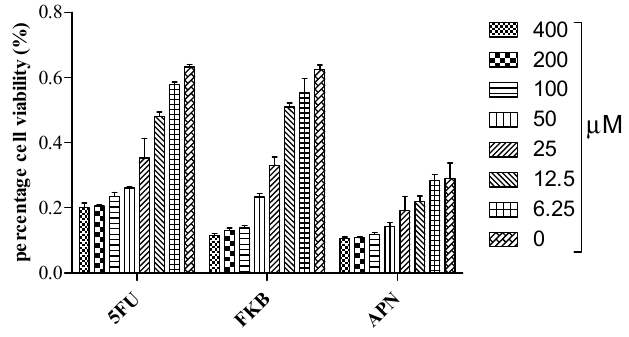
Figure 1. Percentage cell viability of HT 29 cells treated with 5FU, FKB, and APN. MTT assay was used to determine the IC 50 of the drugs at different concentrations in µM for 72 h.